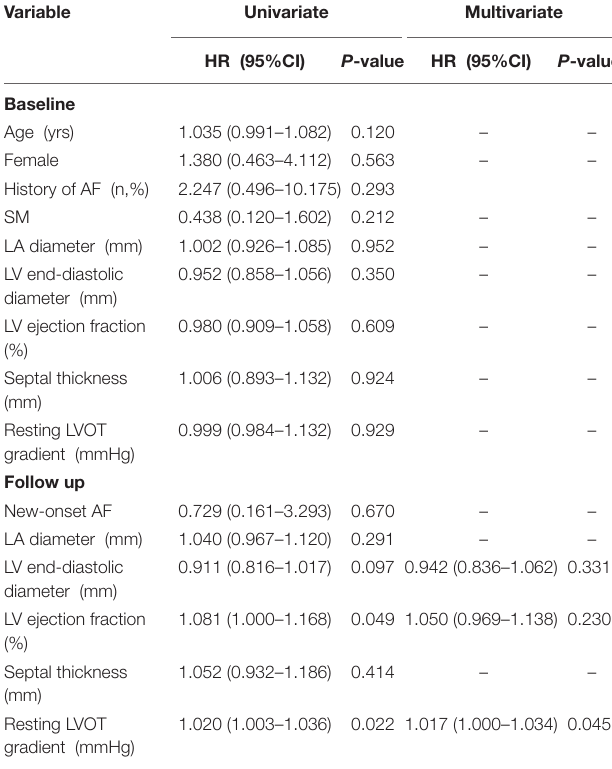
group, whose 5- and 10-year overall survival were 92.9% (95%CI: 87.4% to 98.4%) and 83.0% (95%CI: 72.4% to 93.6%), respectively ( P = 0.197) ( Figure 1 ). 5- and 10-year HCM-related survival for two groups was 98.7% (95%CI: 96.2% to 100.0%) and 98.7% (95%CI: 96.2% to 100.0%) vs. 94.2% (95%CI: 89.1% to 99.3%) and 86.1% (95%CI: 76.3% to 95.9%), respectively ( P = 0.063) ( Figure 2 ). Cox multivariate regression analysis suggested that resting LVOT gradient in the last clinical examination was an independent predictor of all-cause mortality (HR = 1.017, 95%CI: